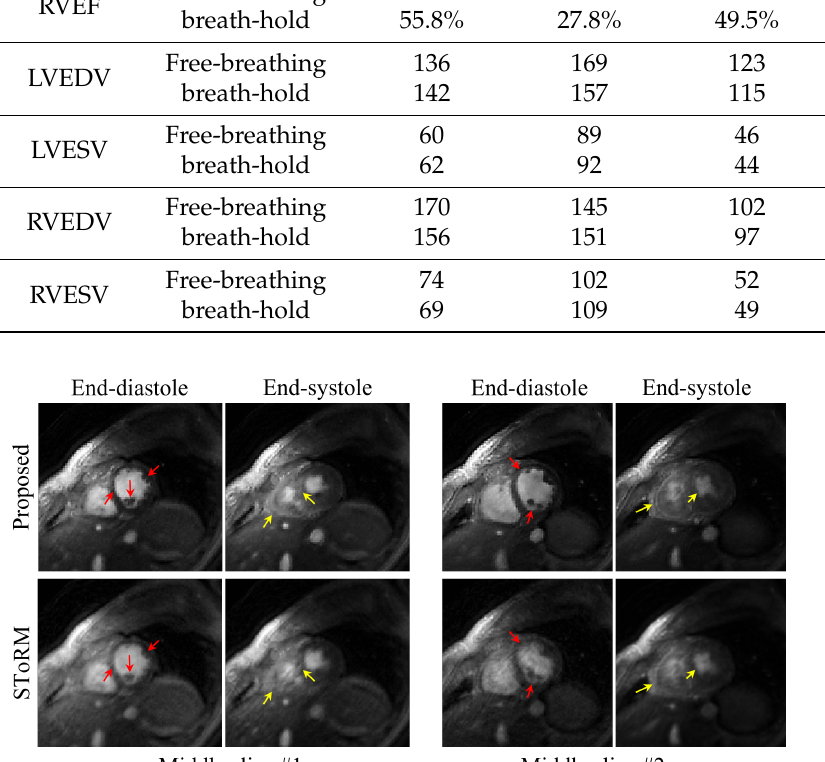
Figure 7. Comparison of the reconstructions from the proposed method and the SToRM method. We showed the end-diastolic and end-systolic phases from two slices acquired from Subject #1. From the images, we can see that the proposed reconstruction scheme can provide images with sharper edges, and the papillary muscles are more visible (illustrated by the red arrows in the images). Furthermore, from the end-systolic images, we can see that the proposed scheme provides reduced motion artifacts, and the RV free-wall is more clear (illustrated by the yellow arrows in the